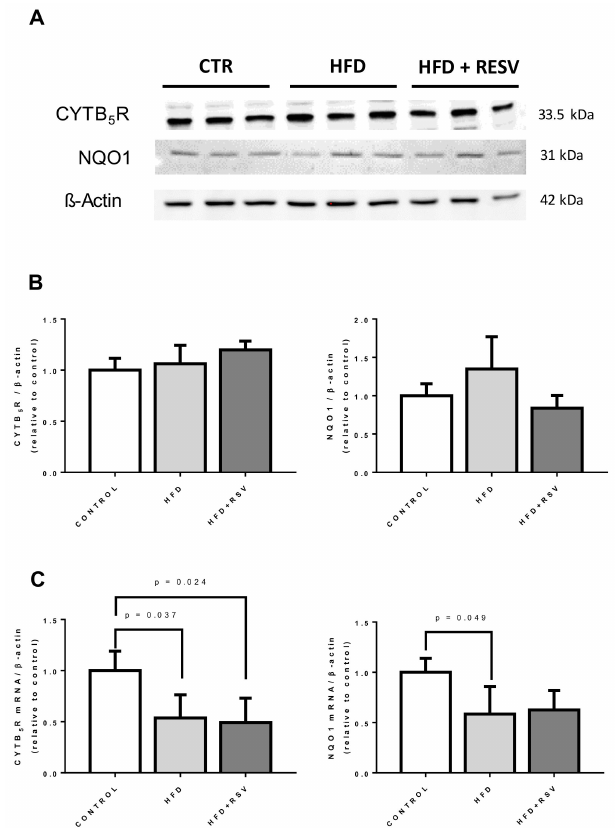
Figure 5. Protein and mRNA levels of CoQ-dependent oxidoreductases in mouse liver. ( A ) Representative western blotting for CYTB 5 R and NQO1 and β -actin in whole liver homogenate from three di ff erent animals per group. ( B ) Quantification of protein levels ( n = 4). ( C ) Levels of mRNA of indicated genes. Statistical significance is indicated in each figure ( n =